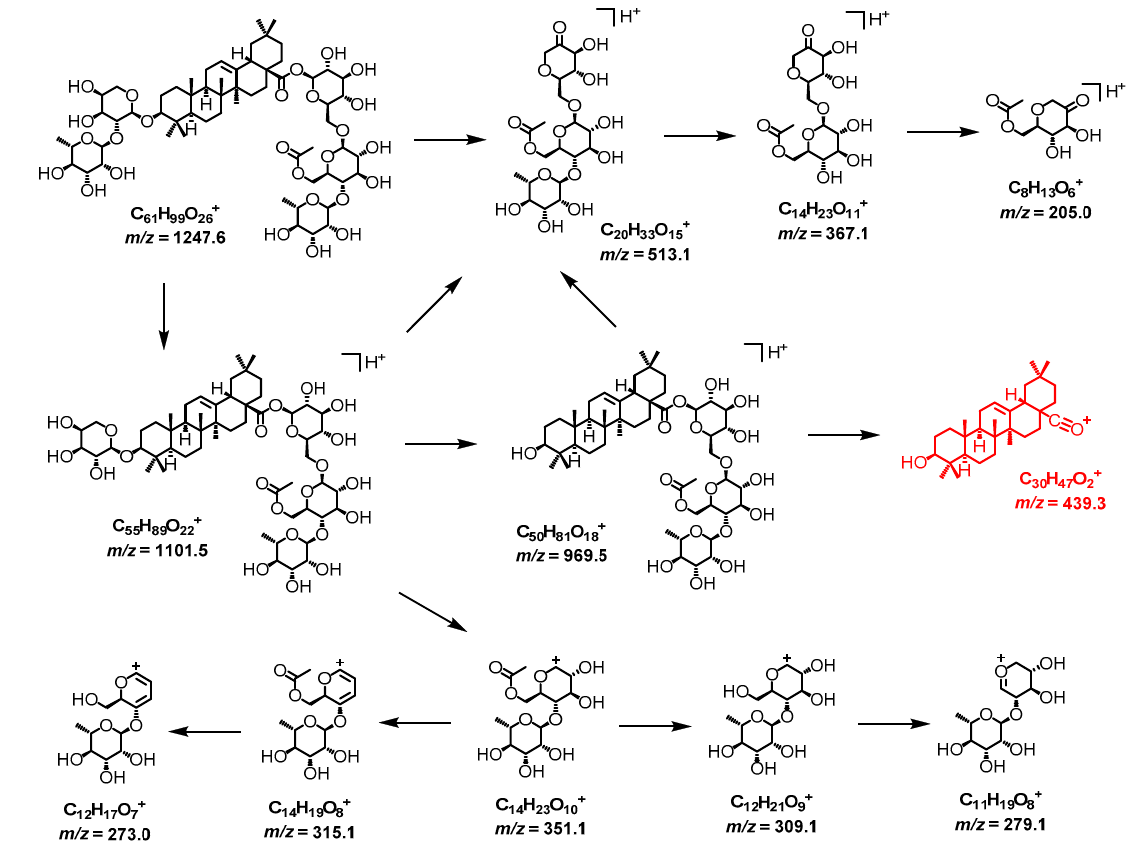
Figure 3. Proposed mass fragmentation pathway for ciwujianoside C4 (key fragment of sub-group II at m/z = 439.3 Da is shown in red color).